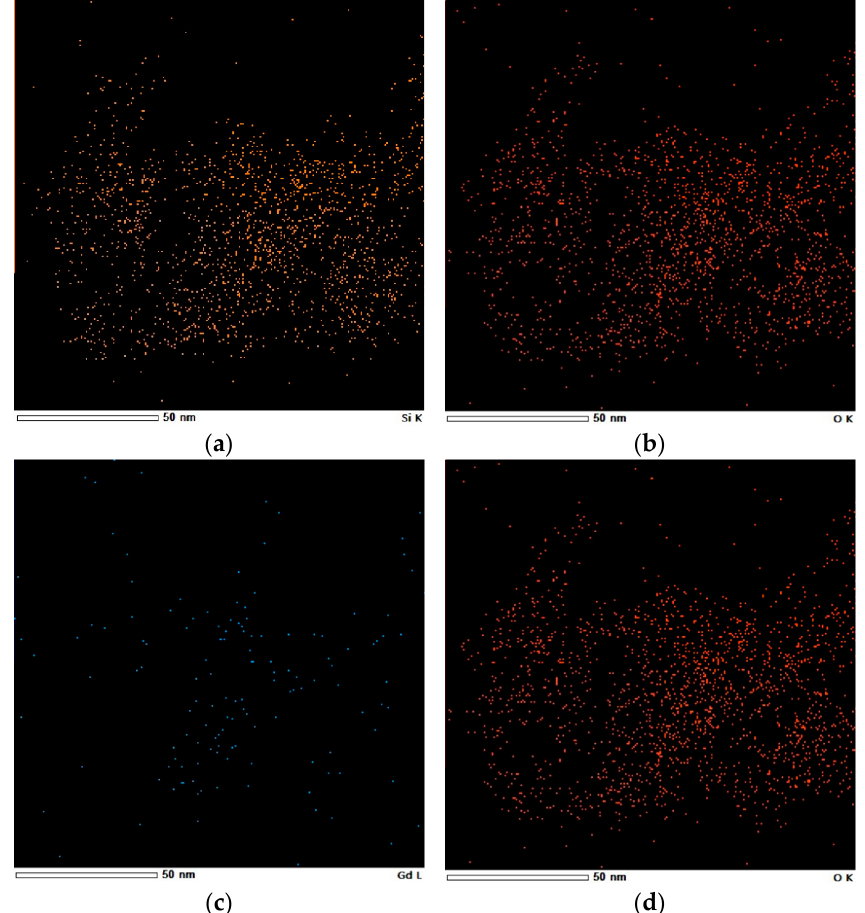
Figure 7. Elemental mapping of ( a ) Si, ( b ) O, ( c ) Gd, and ( d ) Eu in SiO 2 -Gd 2 O 3 :Eu 3+ (1%), showing the distribution of these elements in the nanoparticles.